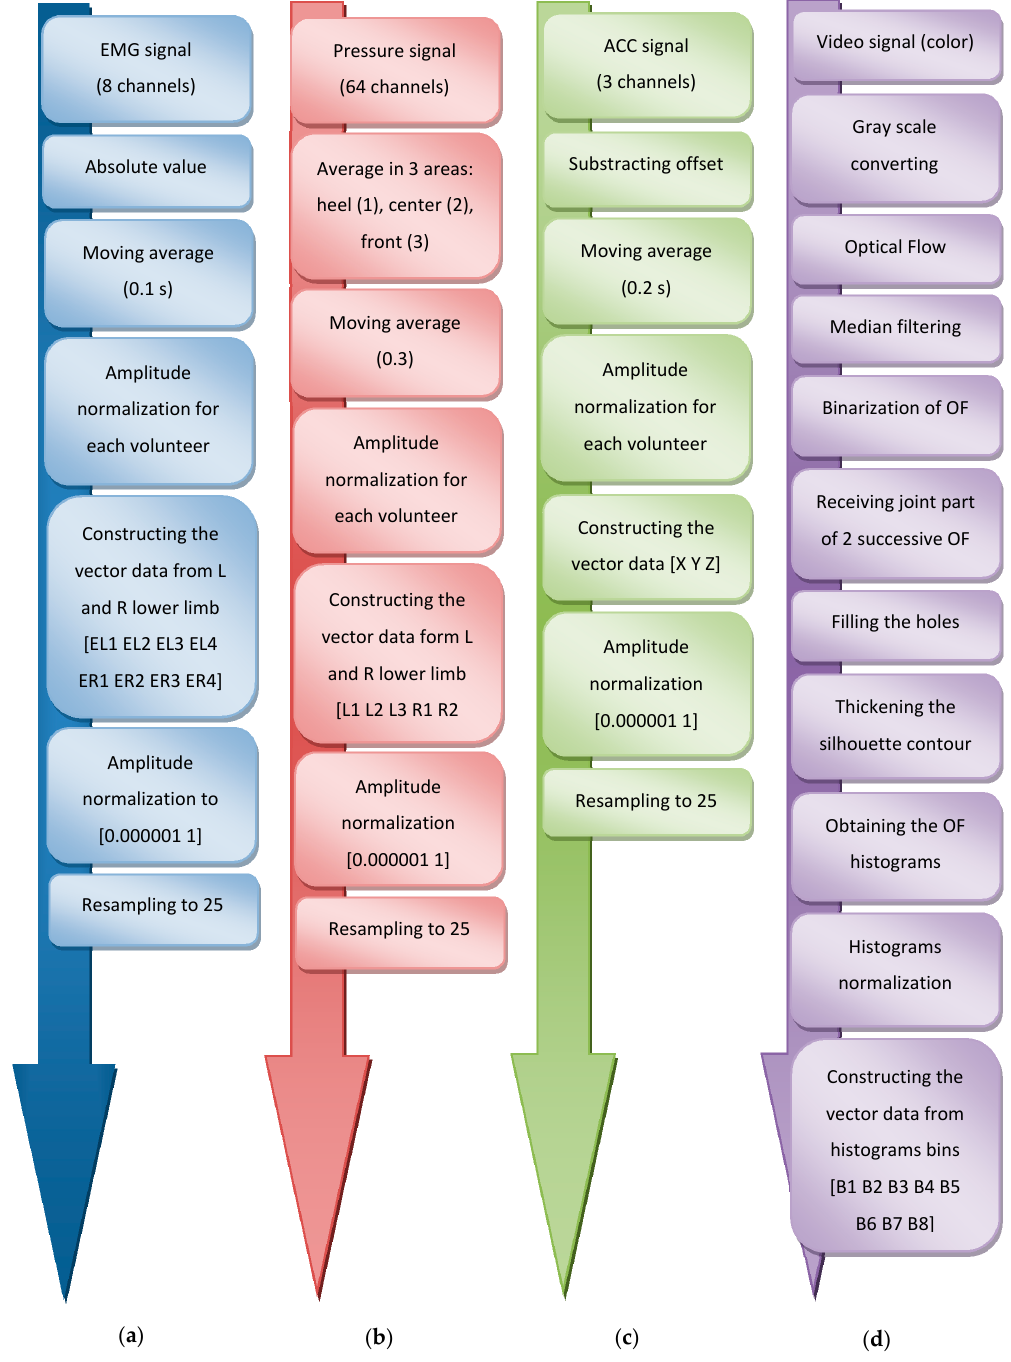
Figure 2. Steps of processing the measurement data from sensors: ( a ) B; ( b ) C; ( c ) D; ( d ) E. L—left, R—right.